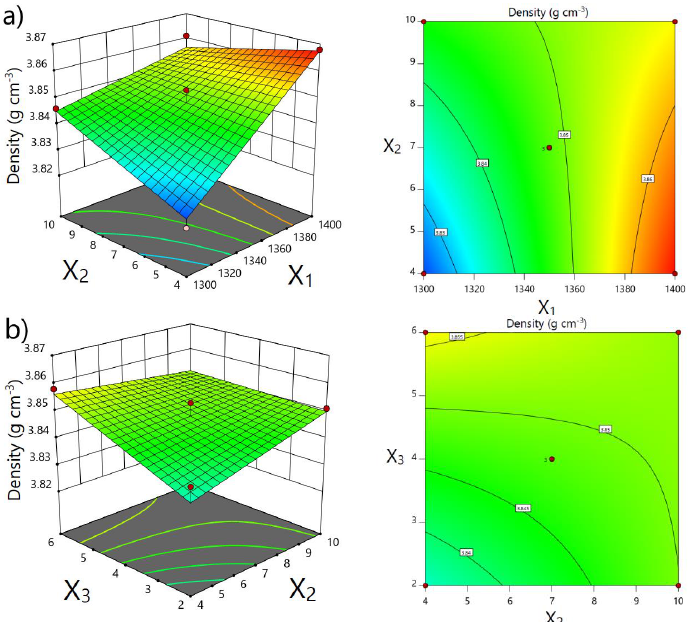
Figure 3. 3D response surface and contour plots depicting influence of: ( a ) sintering temperature of second step (X 1 ) and heating rate (X 2 ) and ( b ) holding time (X 3 ) and heating rate (X 2 ) on apparent density.